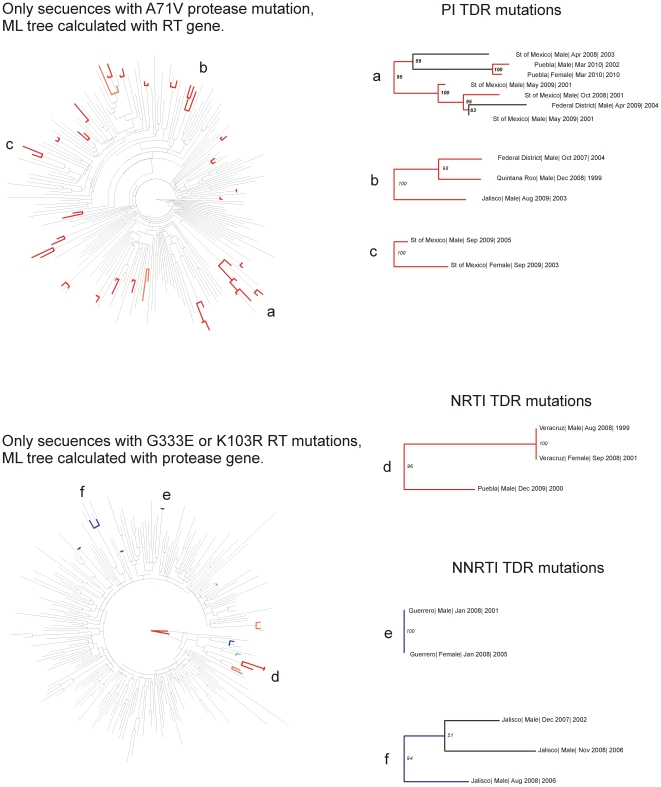
Sub-trees for specific protease and RT TDR mutations.Sub-trees were formed by selecting the patients that had a specific TDR mutation in one of the two genes, from the complete tree based on the other gene (see text for details). Zoom-ins on representative branches are shown on the right, expanding the information on the patients: State | Gender | date of sample collection | probable date of infection. Several branches (e.g. c and e) showed probable transmission pairs, while others formed small clusters with pairs within them (a and d). b and d show cases of widely circulating viruses with TDR mutations. Red lines show branches with boostrap values >90% for A71V and G333E, and blue lines for K103R. Lighter shades show bootstrap support >80%.